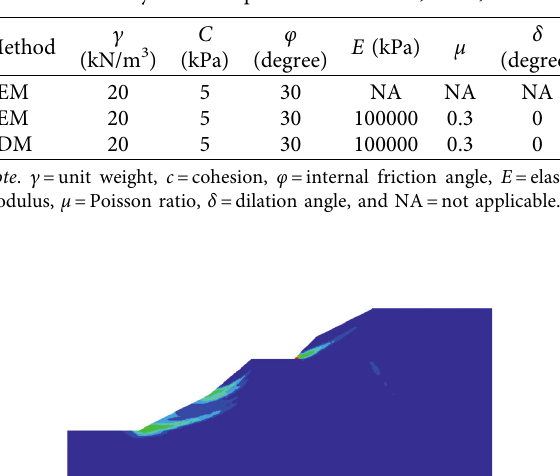
Figure 1: Geometry for multistage slope. Table 1: Summary of model parameters in FEM, FDM, and LEM.